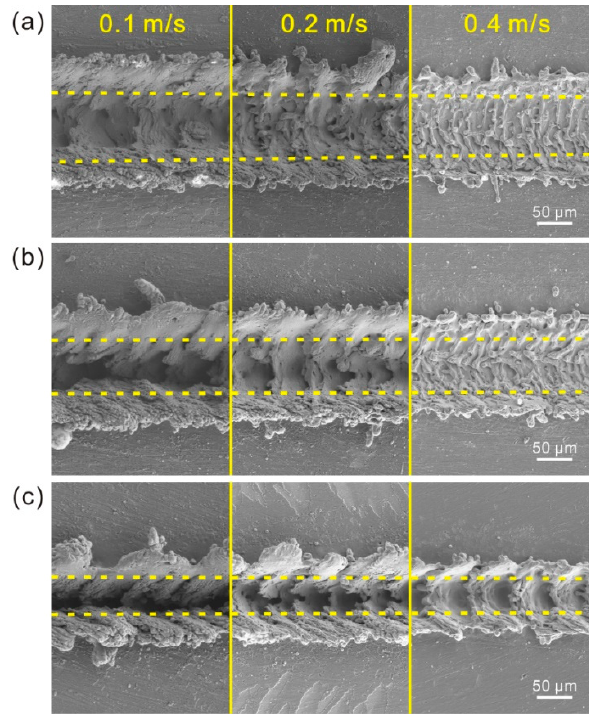
Figure 10. SEM image of the strip microstructure prepared by different laser beam scanning speed: ( a ) 3000 Hz; ( b ) 5000 Hz; ( c ) 8000 Hz.